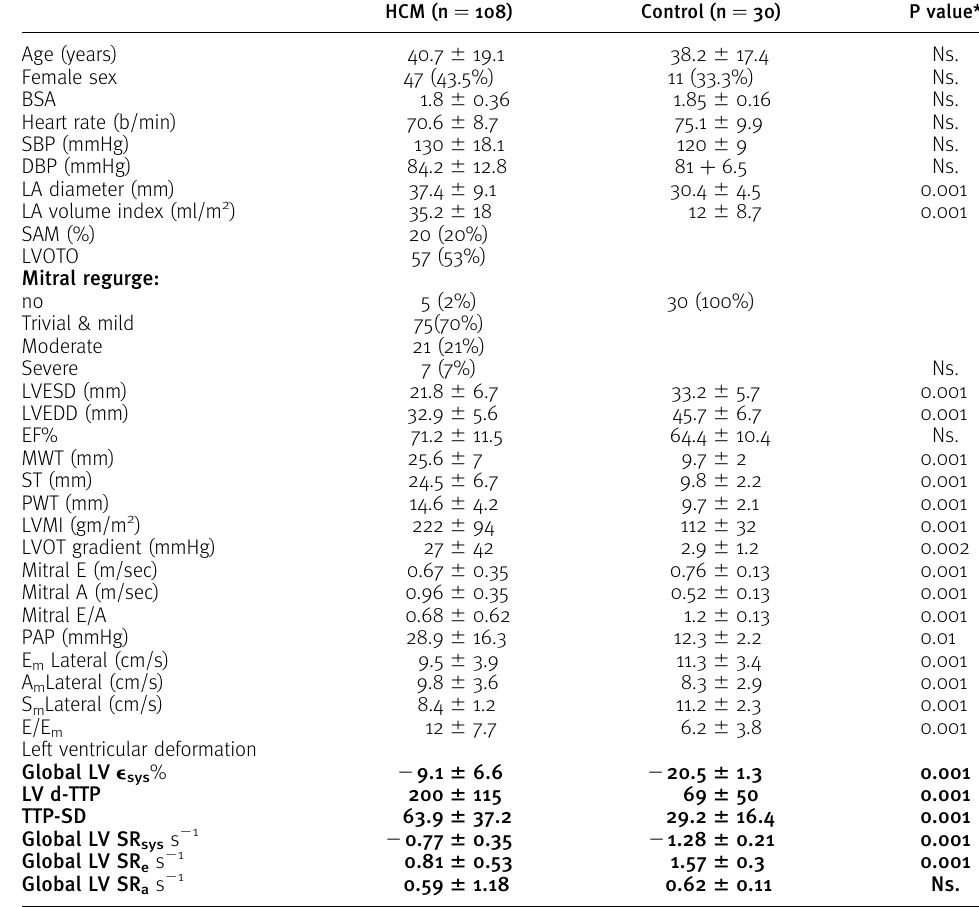
Table 1. Clinical and echocardiographic characteristics of study